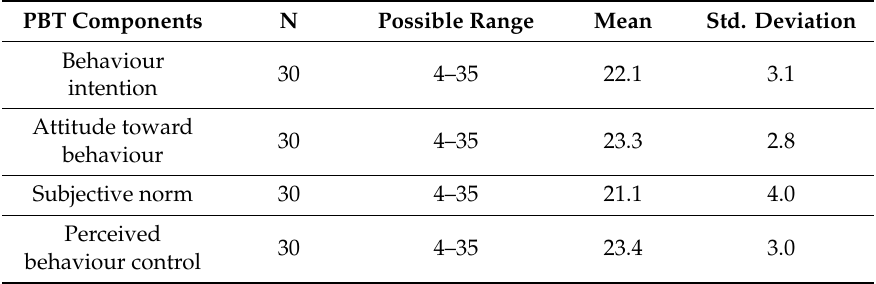
Table 10. Distribution of means and standard deviations for e-TAP